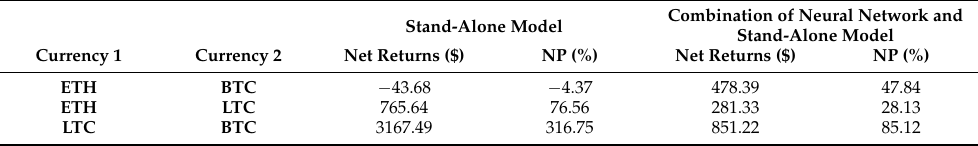
Table 3. Comparison based on returns for pairs